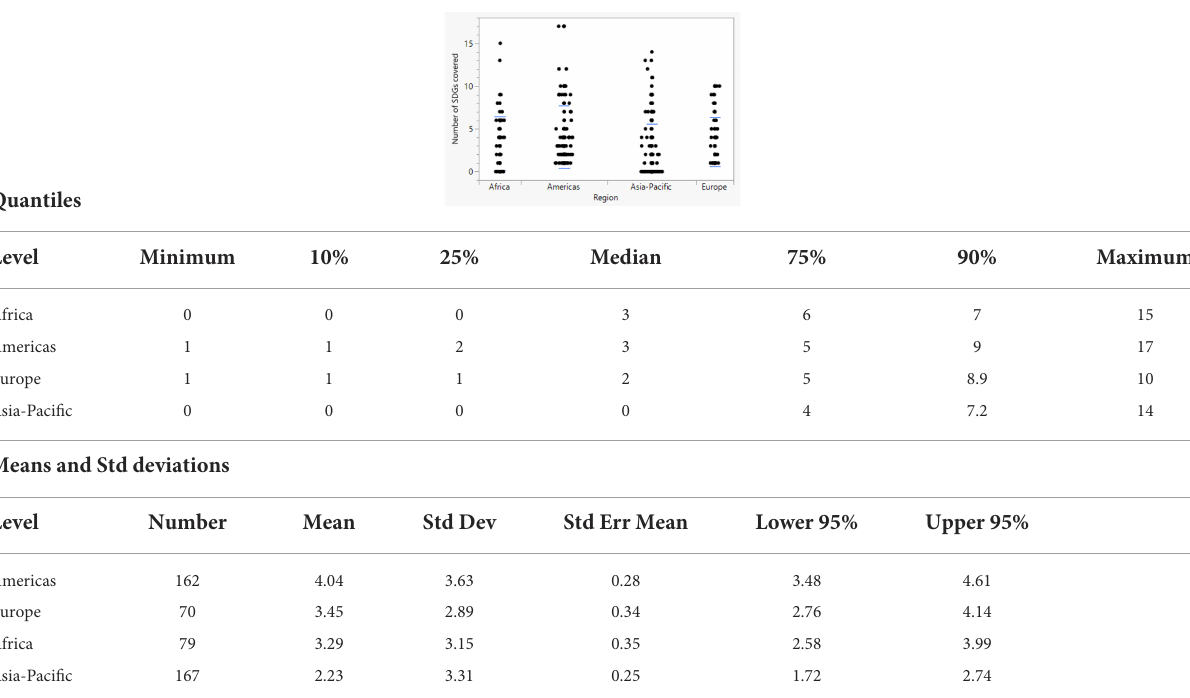
TABLE 2 Number of SDGs covered by